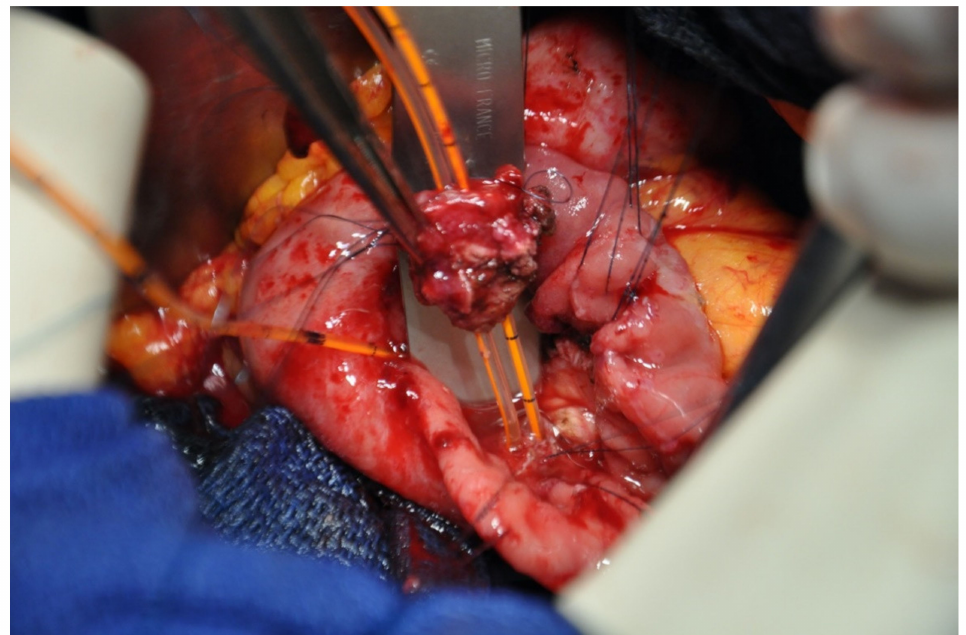
Figure 5. Ampullectomy (surgical